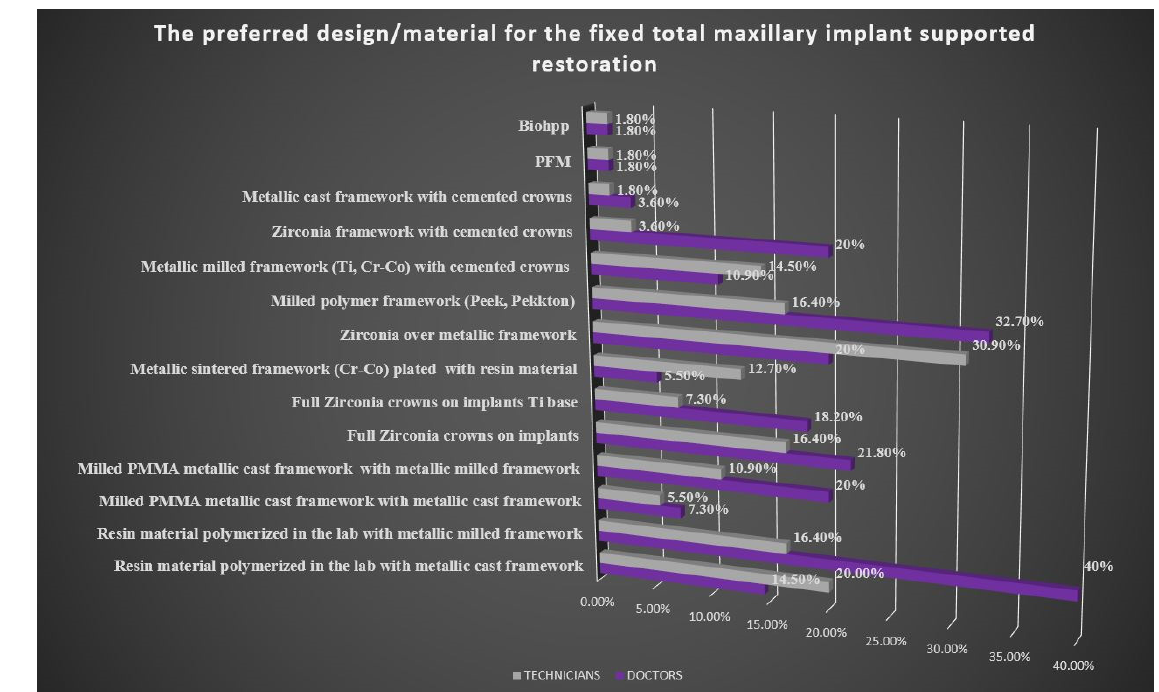
Figure 3. The preferred design/material for the fixed total maxillary implant supported restoration: doctors vs. technicians.